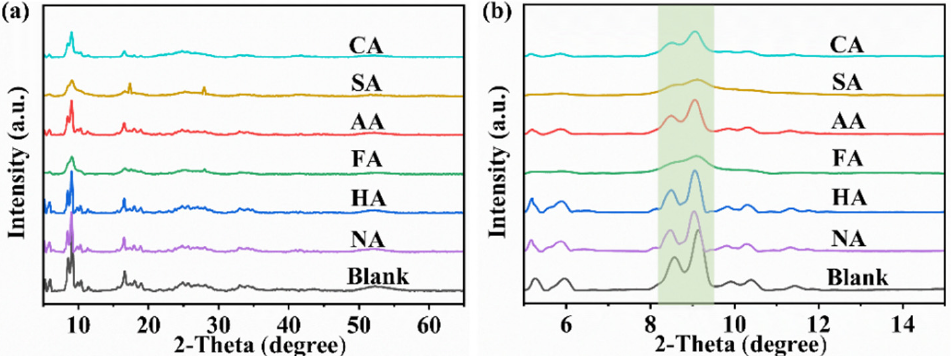
Figure 1. PXRD patterns of the blank sample and MIL-101 (Cr, Sn) synthesized with different modulators. ( a ) 5–65° and ( b ) 5–15°.